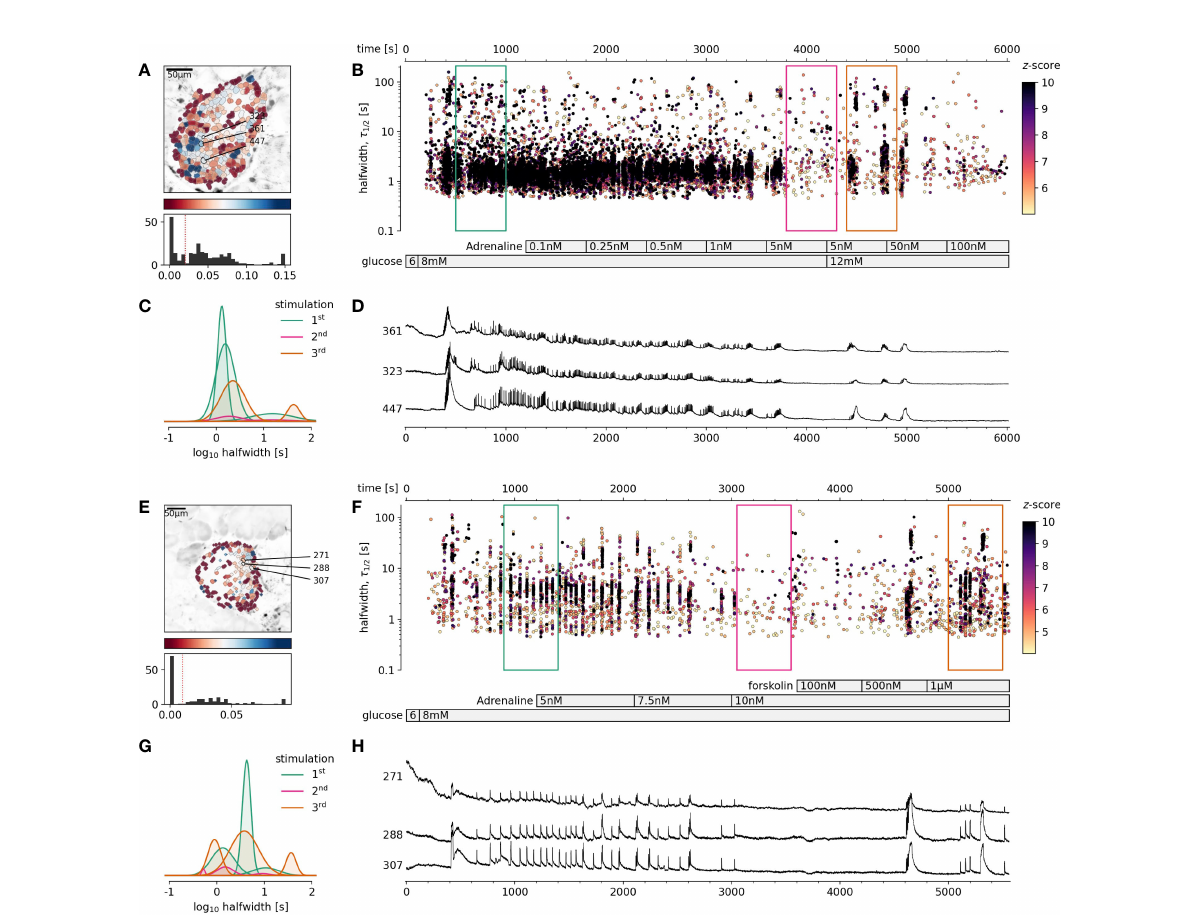
FIGURE 3 The rescue of adrenaline inhibition of 8 mM stimulated beta cell collective activity with higher glucose concentration or forskolin. (A-D) Rescue with 12 mM glucose, (E-H) Rescue with 500 nM foskolin. (A, E) , Regions of interest (ROIs) obtained by our segmentation algorithm. The color indicates the number of events identi fi ed in the ROI trace, upon a high-pass fi ltering at 0.2Hz. We discarded ROIs with number of events below the threshold (red dashed line in the histogram in the lower panel). Indicated are the ROI numbers whose fi ltered traces correlate best with the average trace for the whole islet. (B, F) , [Ca 2+ ] c events ’ halfwidth duration through time. Color indicates the statistical signi fi cance in terms of z -score as indicated. The treatment protocol is indicated in the bar at the bottom of the pane. (C, G) , Normalized Gaussian fi t through the logarithmic distribution of halfwidth duration. (D, H) , Time courses from ROIs indicated in (A, E) , exposed to an increasing concentration of adrenaline or forskolin, and rebinned to 2Hz (recorded at